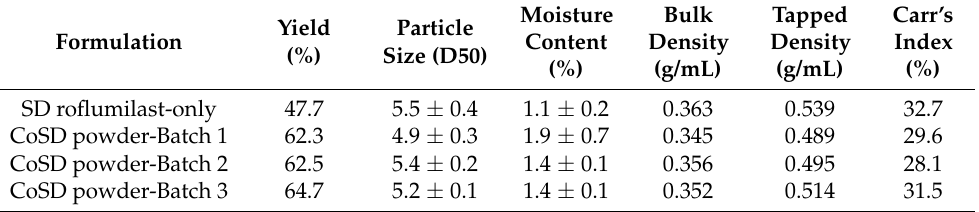
Table 4. Process yield, particle size, moisture content, and flow property of spray ‐ dried (SD) and cospray ‐ dried (CoSD) roflumilast powders produced using the optimized spray ‐ drying conditions. Data are means ± standard deviations, n = 3; yield, bulk density, tapped density, and Carr’s index values are from the single determination of each batch.